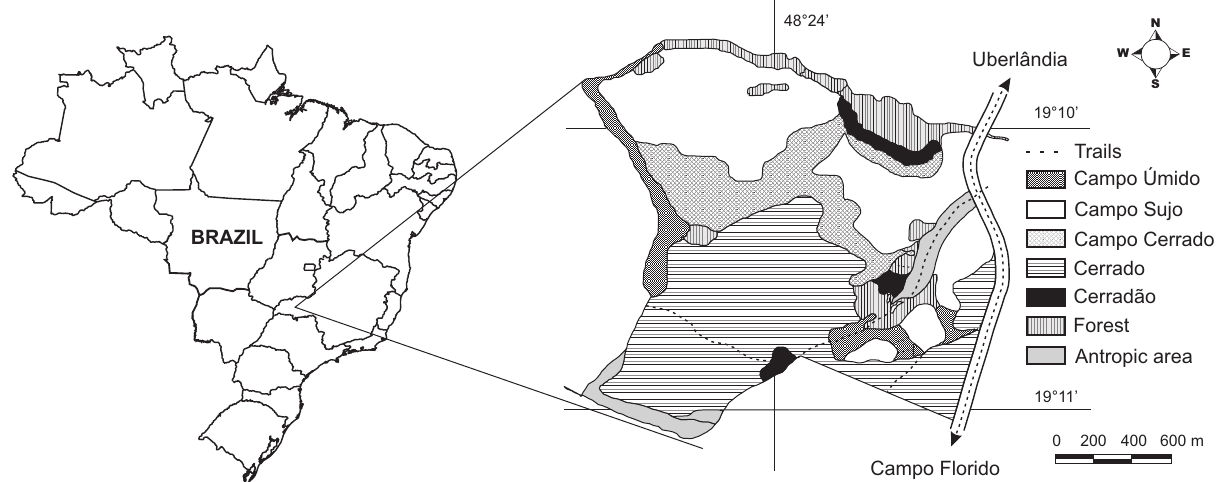
Figure 1. Location of the Panga Ecological Station, an area of preserved Brazilian Savanna. Adapted from S CHIAVINI & A RAUJO (1992).